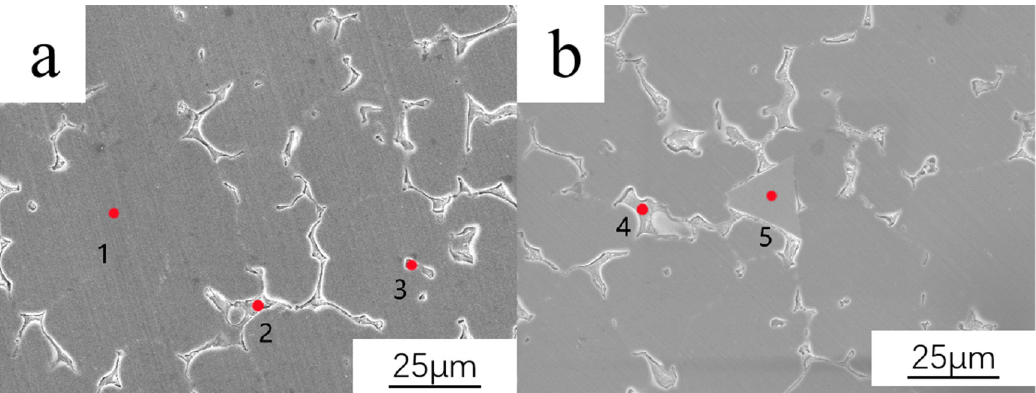
Figure 2. XRD patterns of Al-5Mg-3Zn-1Cu alloys with different Ce content.